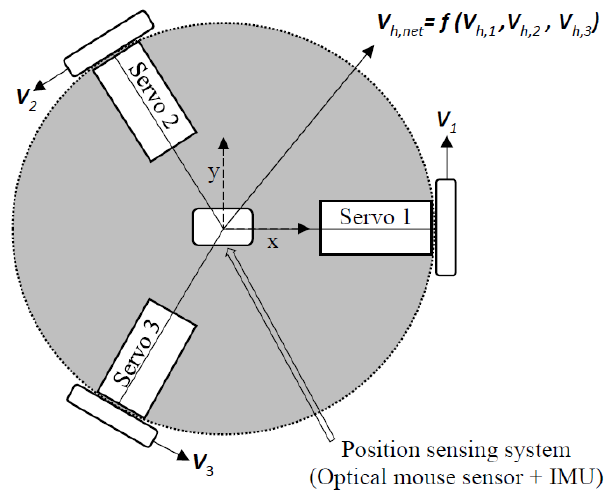
Figure 3. Diagram representing the robot block.